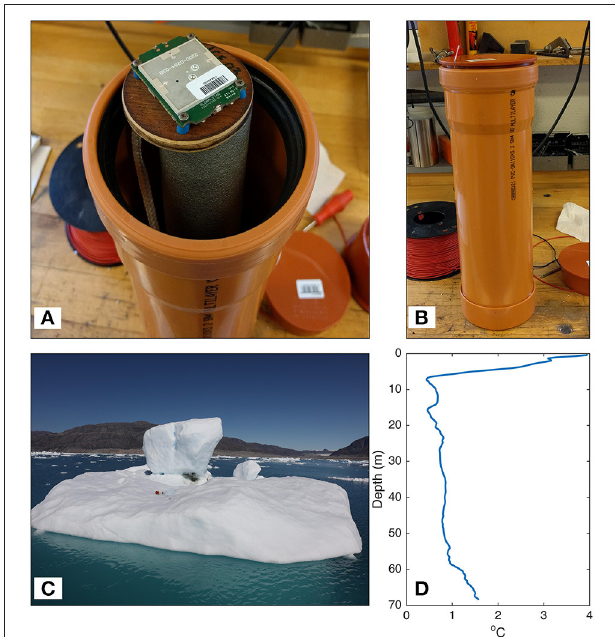
FIGURE 2 | (A) An EXITE tracker showing Spot Trace GPS antenna mounting in a section of PVC drain pipe. (B) An assembled EXITE tracker. (C) EXITE on bergy bit with complex sail geometry resulting from ice debris. (D) A CTD profile of temperature with depth obtained in the vicinity of the EXITE deployment